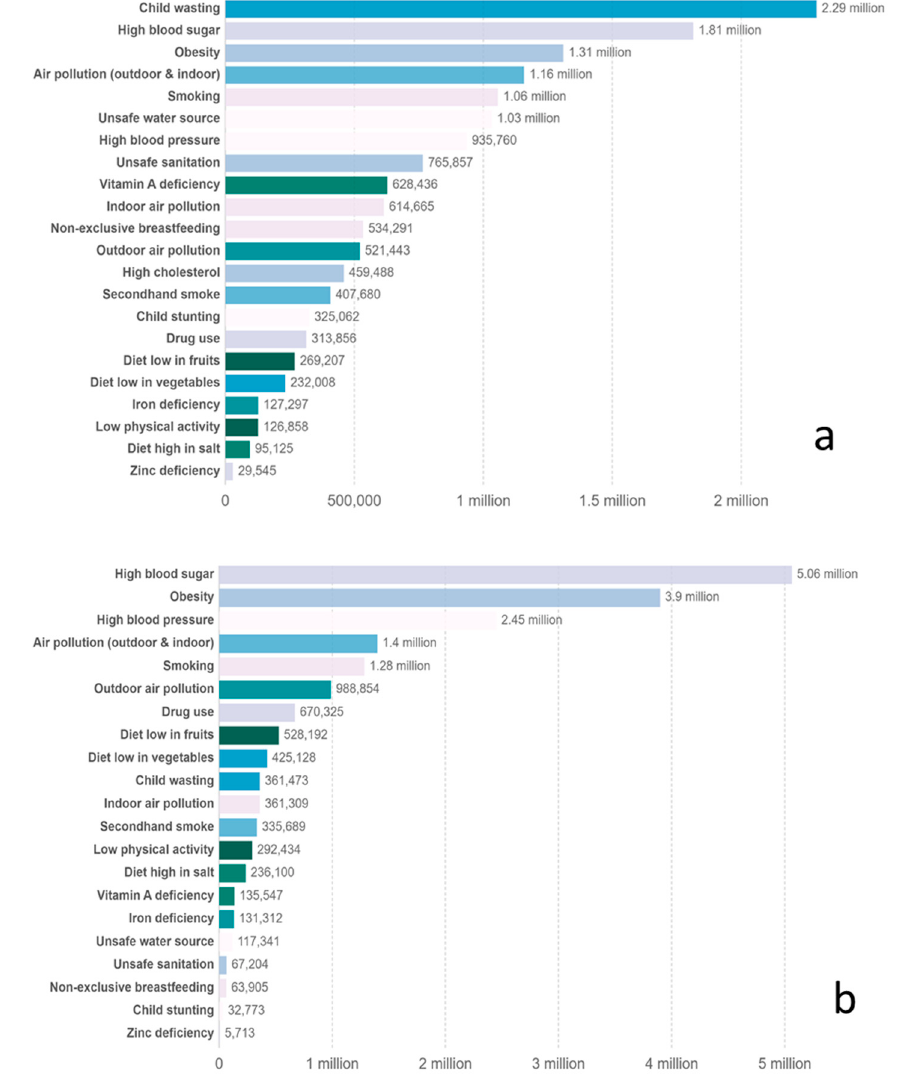
Figure A5. Disease burden by risk factor. ( a ) Data for the Mexican population in 1991. ( b ) Data for the Mexican population in 2017. The disease burden is measured as disability-adjusted life years (DALYs). One DALY is the equivalent of losing one year of good health because of either disability or premature mortality. One DALY represents one lost year of healthy life. Information provided by Institute for Health Metrics and Evaluation [45].